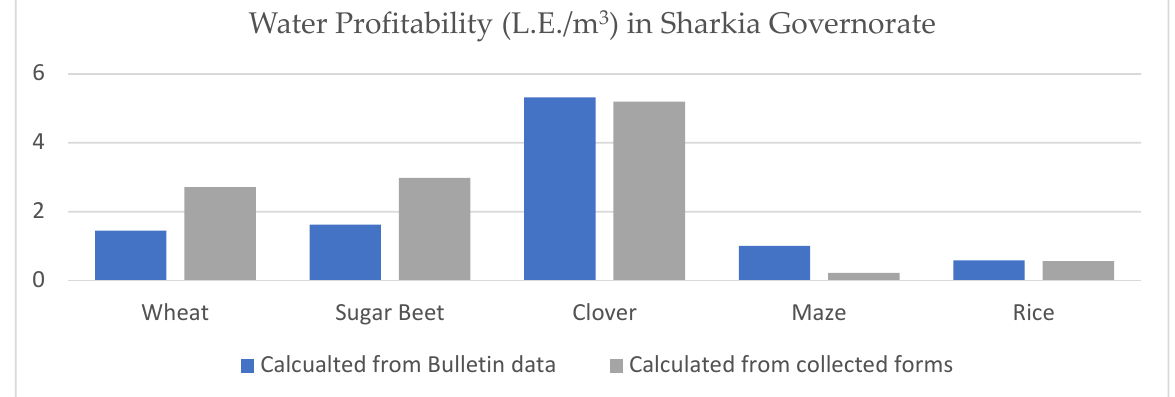
Table 3. Water Profitability Analysis for El-Beheira Governorate in 2020, source: field data collected from farmers and verified by workshops.